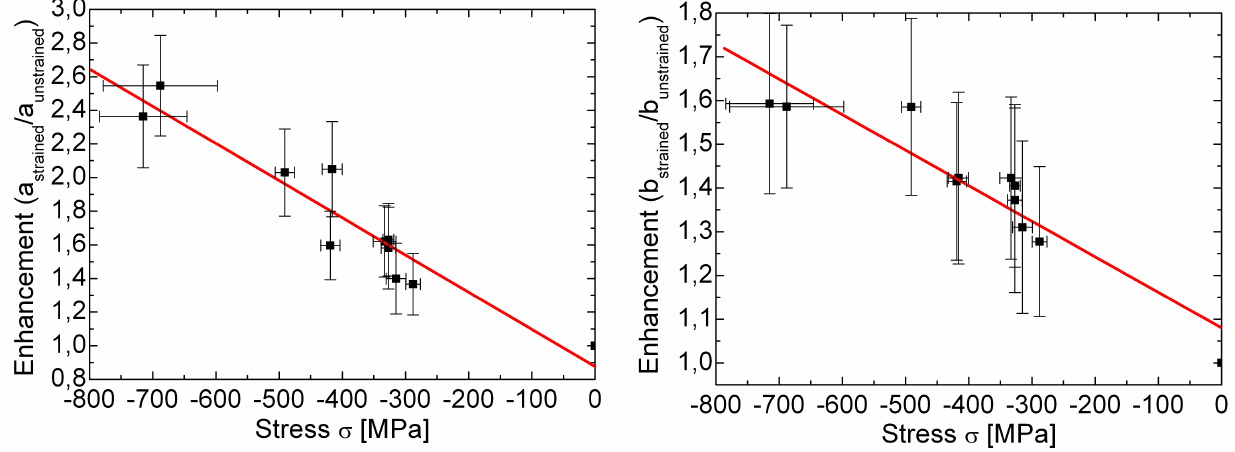
Figure 10. The angular components a Equation 17 versus the stress of the silicon oxide layer on the silicon (111)